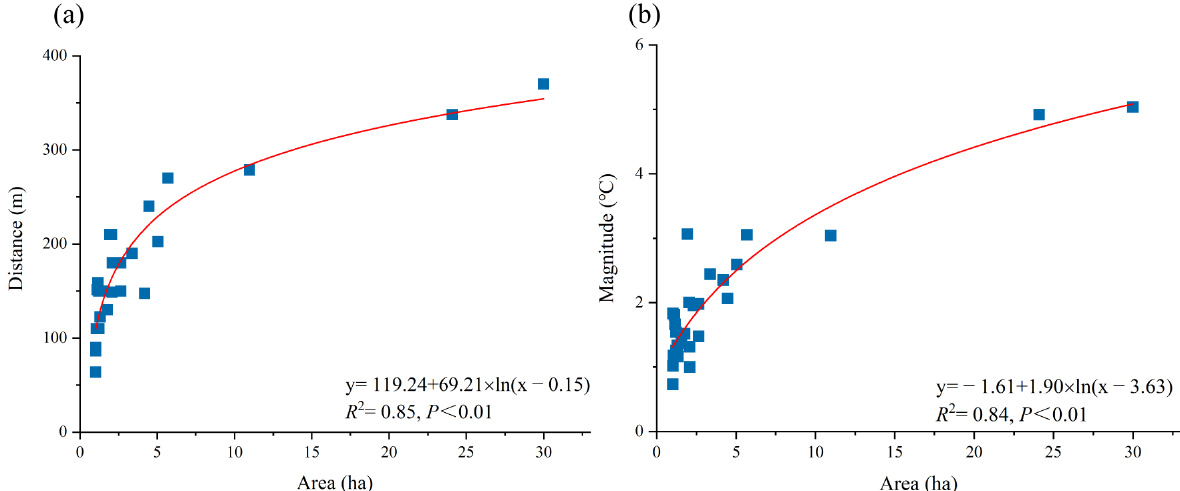
Figure 6. Relationship between blue space area and cooling distance/magnitude. ( a ) area VS cooling distance; ( b ) area VS cooling magnitude.